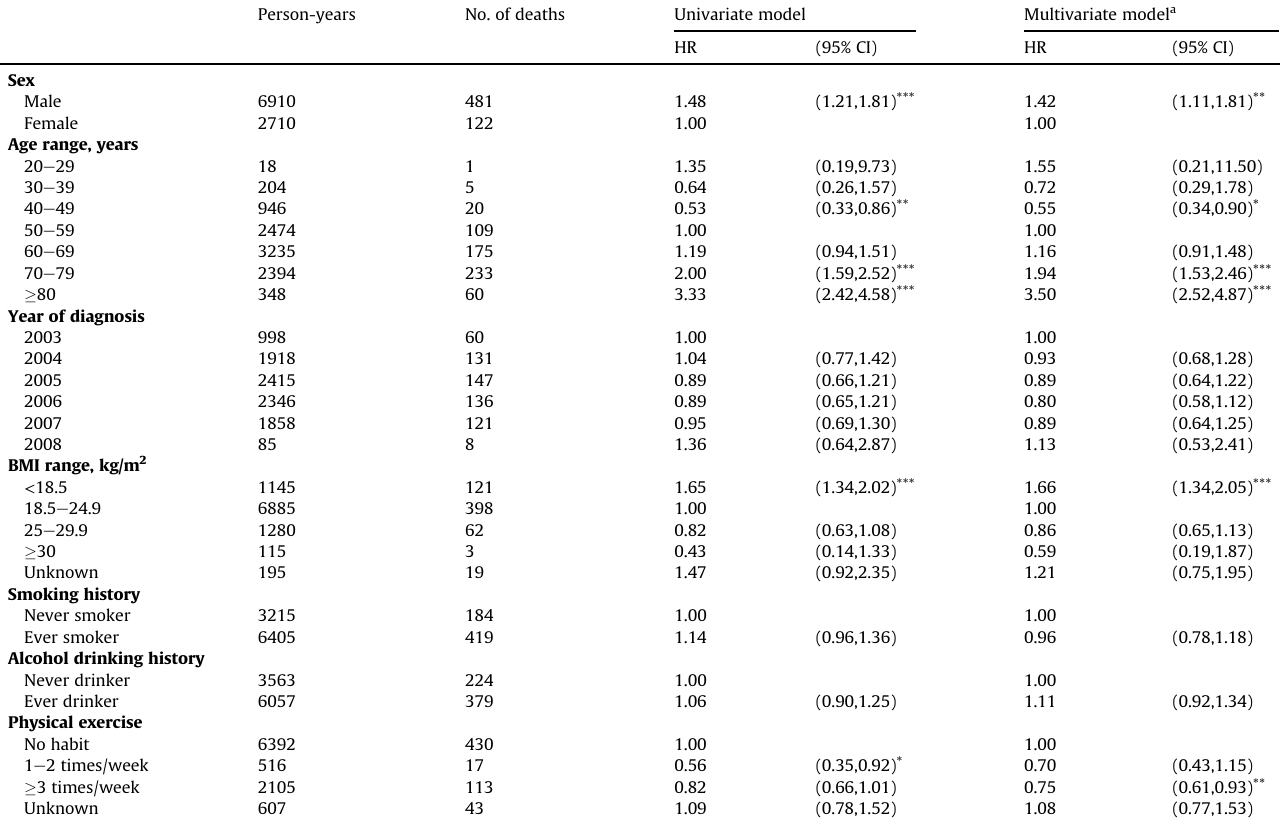
Table 4 HRs and 95% CIs for mortality according to demographic and lifestyle factors among patients with gastric cancer in the Biobank Japan Project (n ¼ 1574). Person-years No. of deaths Univariate model Multivariate model